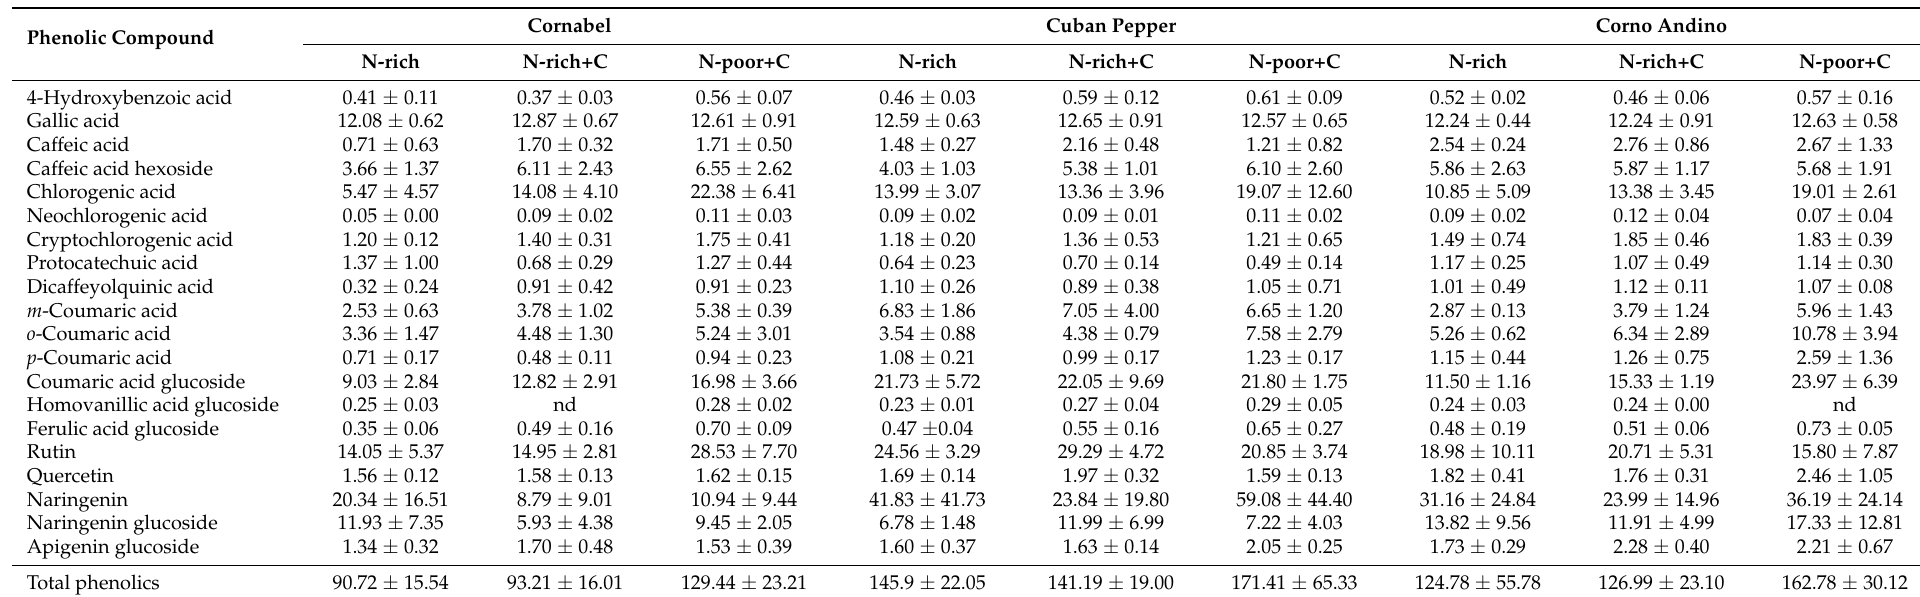
Table 7. Concentrations of the phenolic compounds (mg/kg) in the Pebroter tomatoes according to the fertilization used. Phenolic